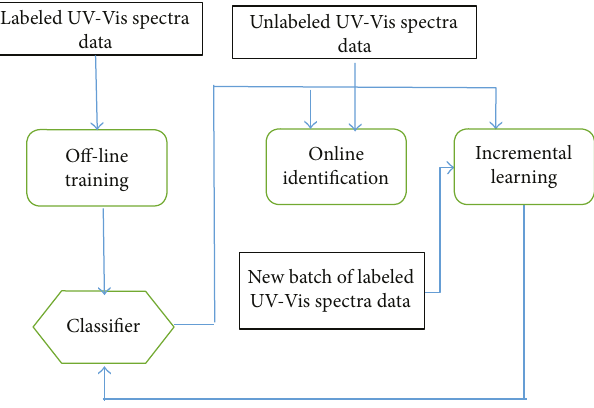
Figure 1: Incremental learning SVM algorithm